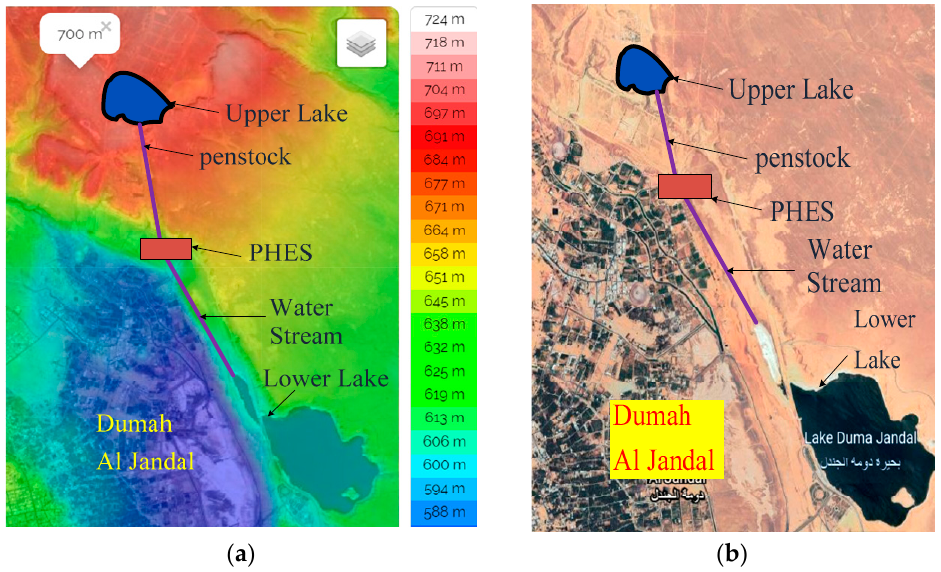
Figure 2. The proposed HRES in Dumah AlJandal site. ( a ): Topological view [33] .Reproduced from [33], Topographic maps: 2021. ( b ): GOOGLE EARTH view.